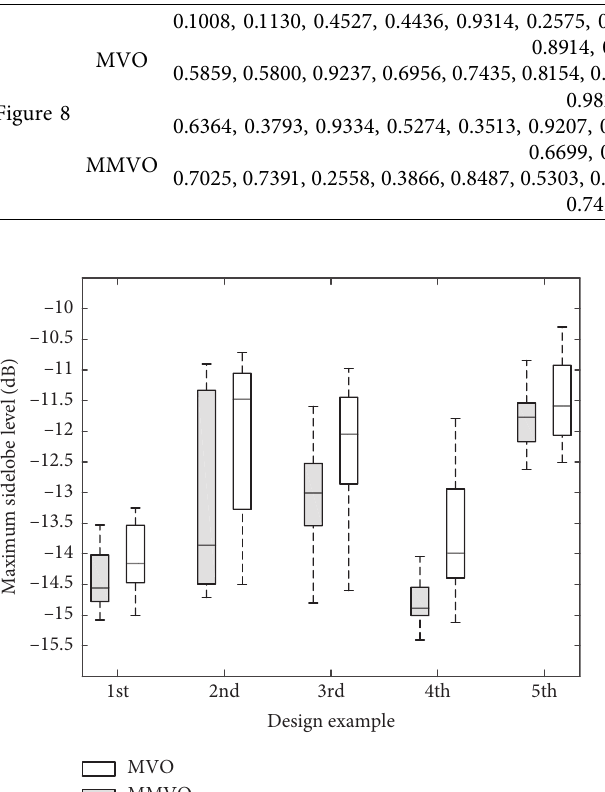
Figure 9: Box-and-whisker plots of design examples 1, 2, 3, 4, and 5 for 20